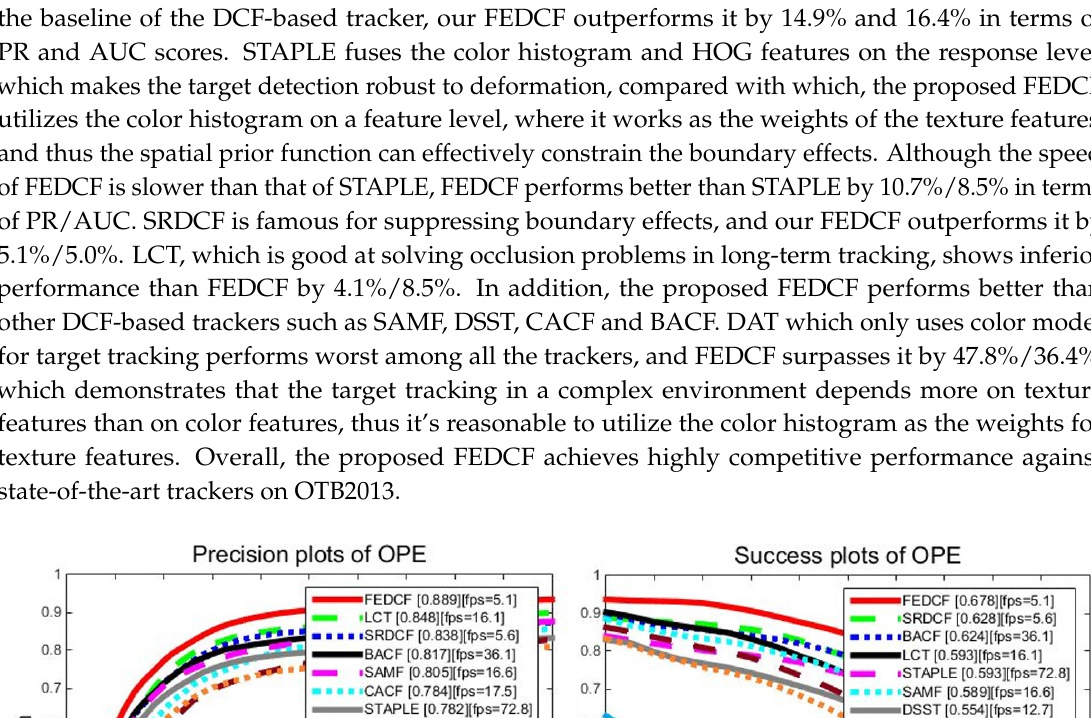
Figure 9. The precision plots and success plots of FEDCF and compared trackers with one-pass (OPE) evaluation on OTB2015, which expands the contained sequences to 100 challenging sequences with 11 challenging attributes. 4.3.2. Attribute-Based Evaluation For a more detailed analysis of trackers’ performances in different scenarios, the one-pass evaluations of trackers in term of precision plots on different challenging scenarios are shown as Table 3. Table 3. The one-pass evaluation of FEDCF and compared trackers in term of PR score on OTB2015. The top three scores are highlighted in red, green and blue respectively. FEDCF